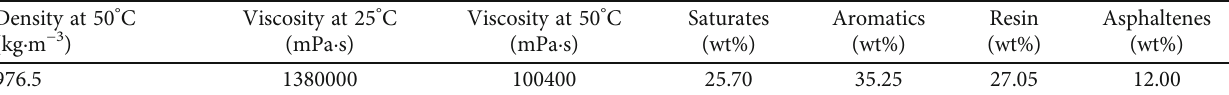
Table 1: Properties of ultraheavy oil from Venezuela.